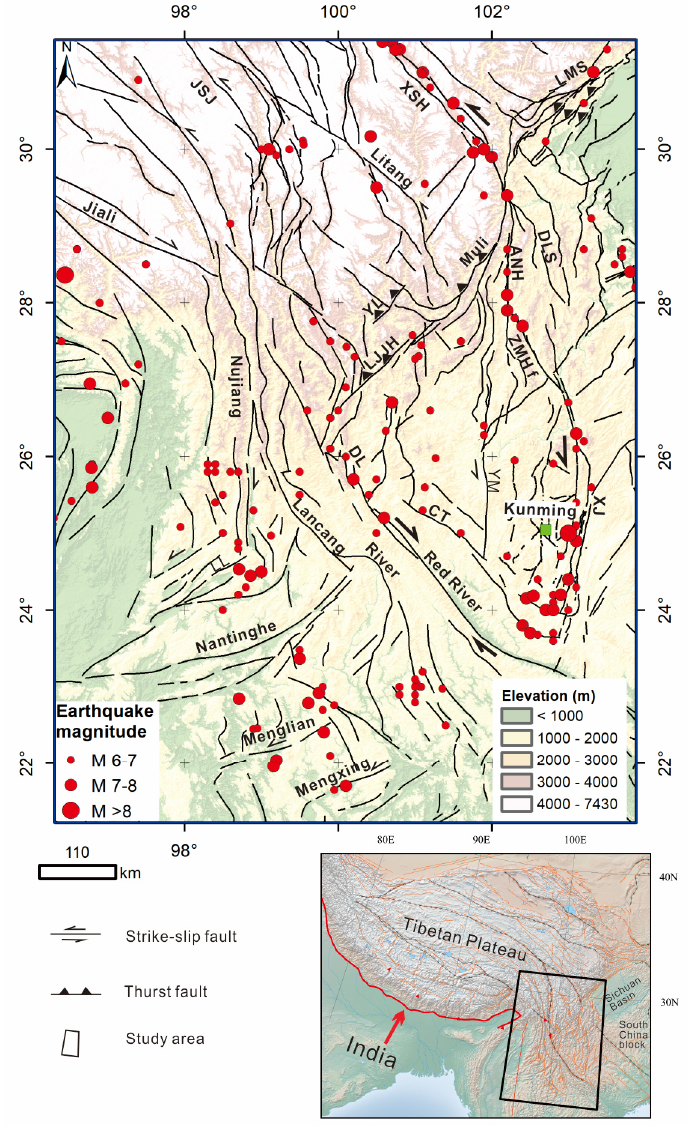
Figure 1. Major faults and seismicity on the southeastern margin of the Tibetan Plateau [23,24]. Instrumentally recorded earthquakes are from the USGS, and historical earthquakes are from China Earthquake Administration (1995, 1999). The shaded topography is derived from 30-m resolution Shuttle Radar Topography Mission data (USGS). Abbreviations are ANH: Anninghe fault, CT: Chuxiong Tonghai fault, DL: Dali fault, DLS: Daliangshan fault, LJJH: Lijiang Jinhe fault, JSJ: Jinshajiang fault, XSH: Xianshuihe fault, XJ: Xiaojiang fault, LL: Longling fault, LMS: Longmenshan, YM: Yuanmou fault, YL: Yulong fault, and ZMH: Zemuhe fault. Geomorphological evidence has been central in revealing active fault system defor- mation rates and spatial distribution [25]. Quantitative analyses of geomorphic evidence